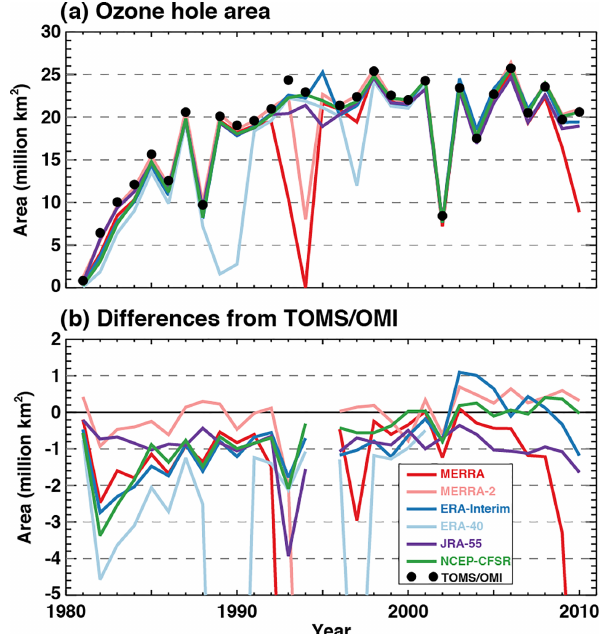
Figure 9. (a) Ozone hole mean area calculated from TOMS/OMI observations and the reanalyses for 21 September through 20 Octo- ber of 1981–2010. (b) Differences between ozone hole mean areas from reanalyses and TOMS/OMI observations ( R i −